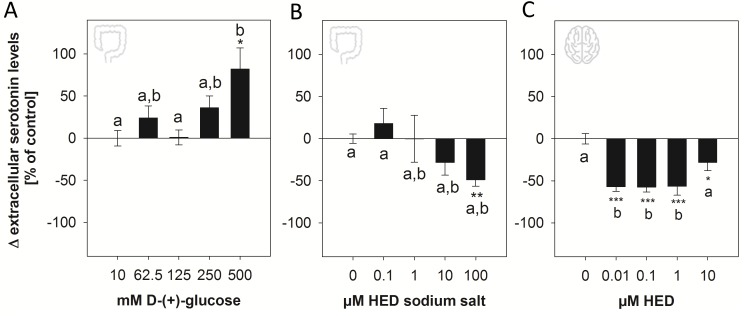
(A) Serotonin levels in the supernatant of differentiated Caco-2 cells after stimulation with 125 to 500 mM D-(+)-glucose for five minutes. (B) Serotonin levels in the supernatant of differentiated Caco-2 cells after stimulation with 0.01–100 μM HED sodium salt for five minutes. (C) Serotonin levels in the supernatant of SH-SY5Y cells after stimulation with 0.001–10 μM HED after five minutes. Krebs-Ringer buffer containing 10 mM D-(+)-glucose was used as control in all studies and was set to 100%, the treatments are depicted as the mean change of extracellular serotonin levels in percent of the control ± SEM. Statistics: n = 3–6 with at least two technical replicates. Significant differences between the treatments were assessed using one-way ANOVA with Holm-Sidak post hoc test and are marked by * p <0.05, ** p <0.01, *** p <0.001 vs. control and with distinct letters for differences between the groups.